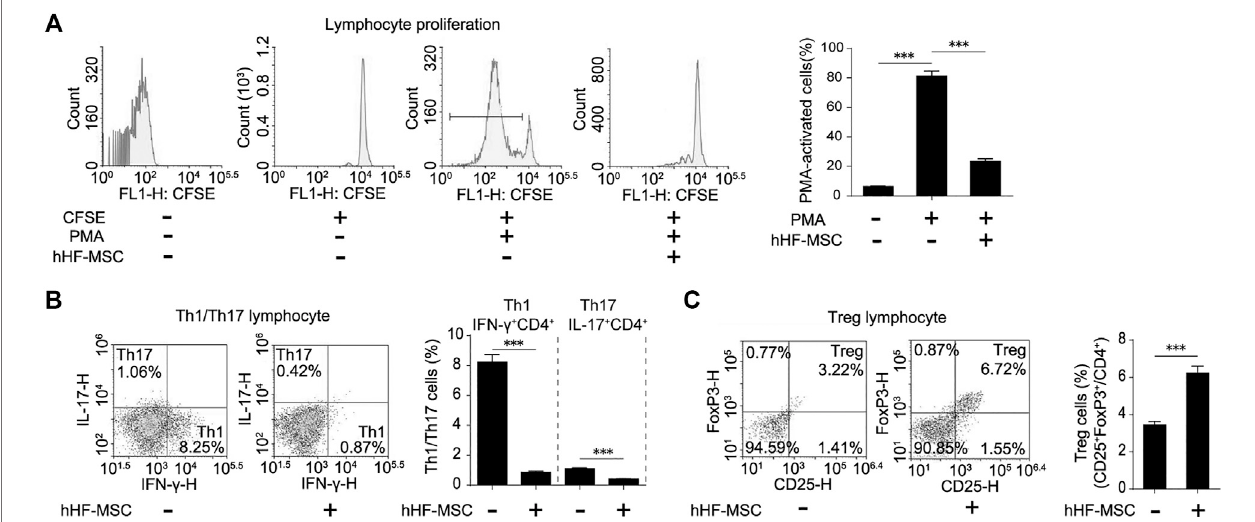
FIGURE 3 | Immunomodulatory effects of hHF-MSCs. (A) Flow cytometry analysis and quanti fi cation on growth suppression of PBMCs in co-culture with hHF- MSCs for 3 days. (B) Flow cytometry analysisand quanti fi cation on differentiation of Th1 and Th17 inco-culture with hHF-MSCs for 3 days. (C) Flow cytometry analysis andquanti fi cationondifferentiationofTreginco-culturewithhHF-MSCsfor3 days.Allthedatawereobtainedfromthreeindependentexperiments.Datawereshownas the means ± s.e.m. *: p < 0.05, **: p < 0.01, ***: p < 0.001, NS: not signi fi cant.